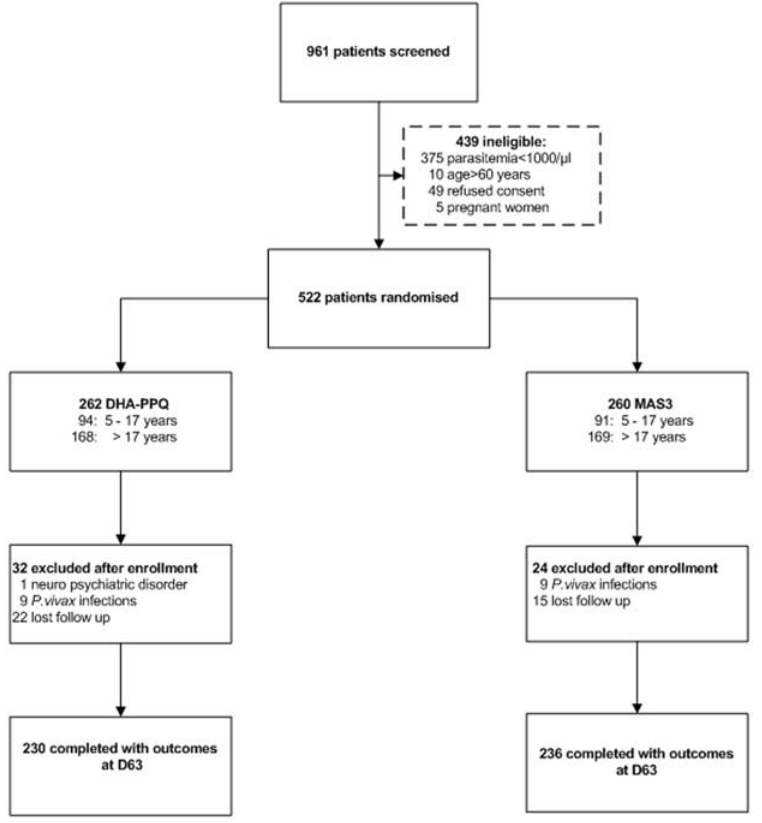
Figure 1. Trial profile.